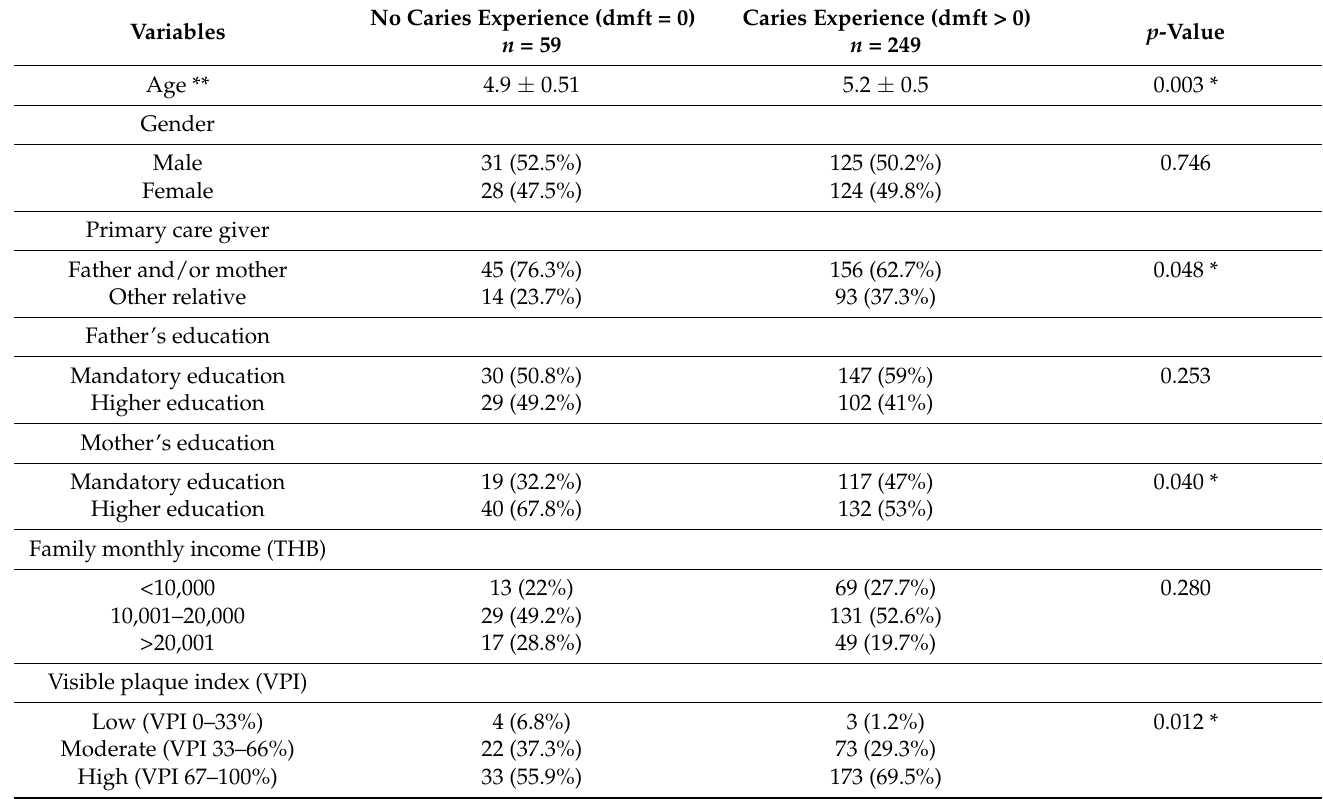
Table 2. Association between caries experience and children’s demographic background and dental plaque.